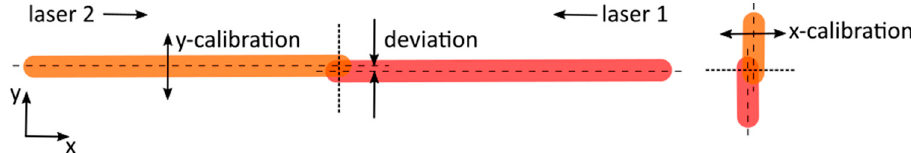
Figure 3. Illustration of the procedure for spatial calibration.